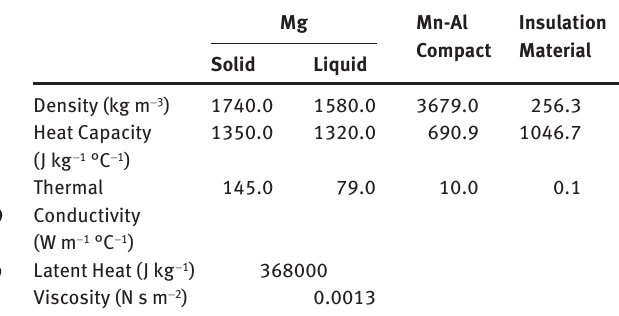
Fig. 4: IHTP flow chart for estimating effective thermal conductivities of compacts Table 2: Thermo-physical properties used in FLOW-3D